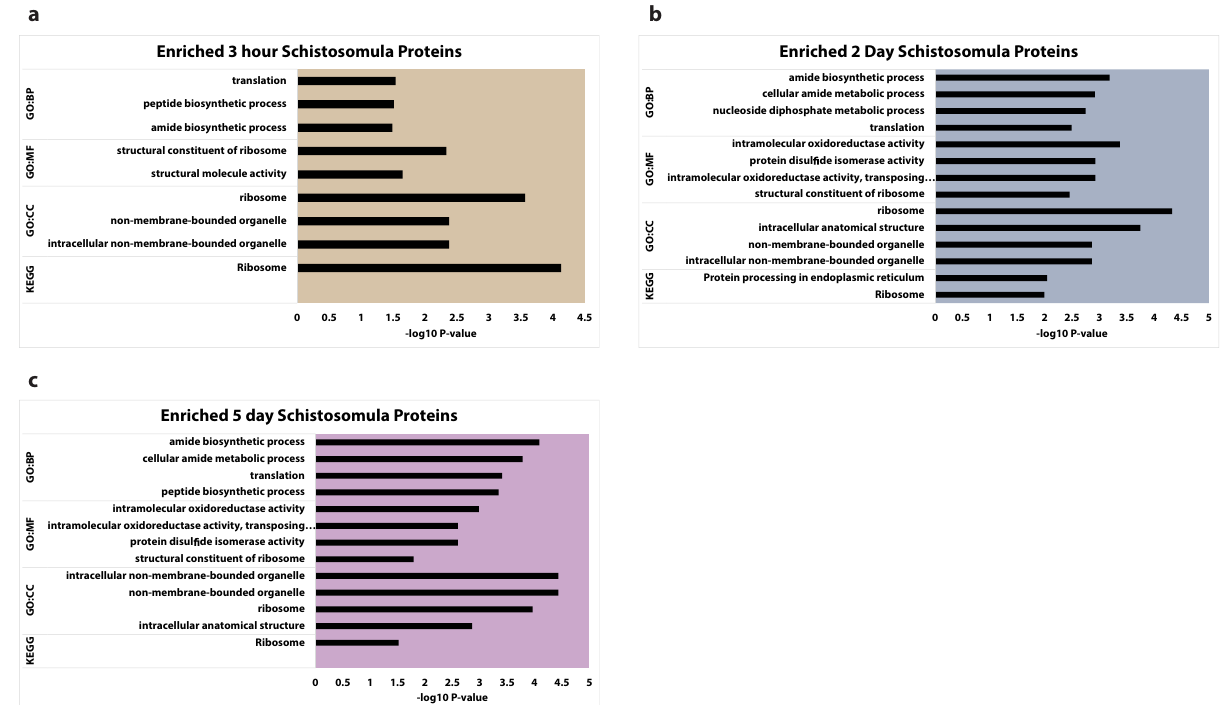
Fig. 4 GO analysis of enriched proteins in developing schistosomula. Schistosomula are signi fi cantly enriched for ribosomal component proteins at all three developmental time points analyzed. Over-expressed proteins from 3 h, 2 day, and 5 day schistosomula were re-analyzed from publicly available data published by Sotillo et al. 2015 19 . a represents enriched GO categories for overexpressed proteins in 3 h schistosomula, b represents the same for 2 day schistosomula, and c represents the same for 5 day schistosomula. All supporting GO analysis data is contained in Supplementary Data